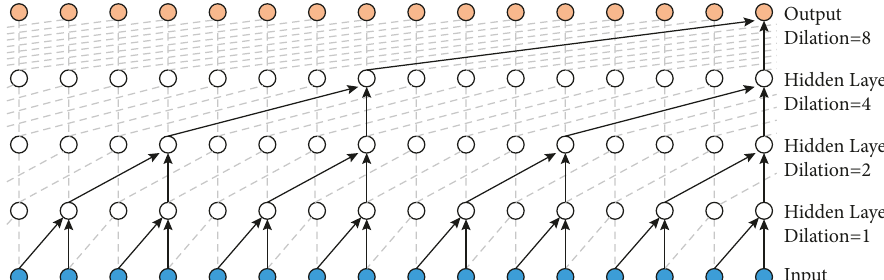
Figure 2: A dilated causal convolution with dilation factors d